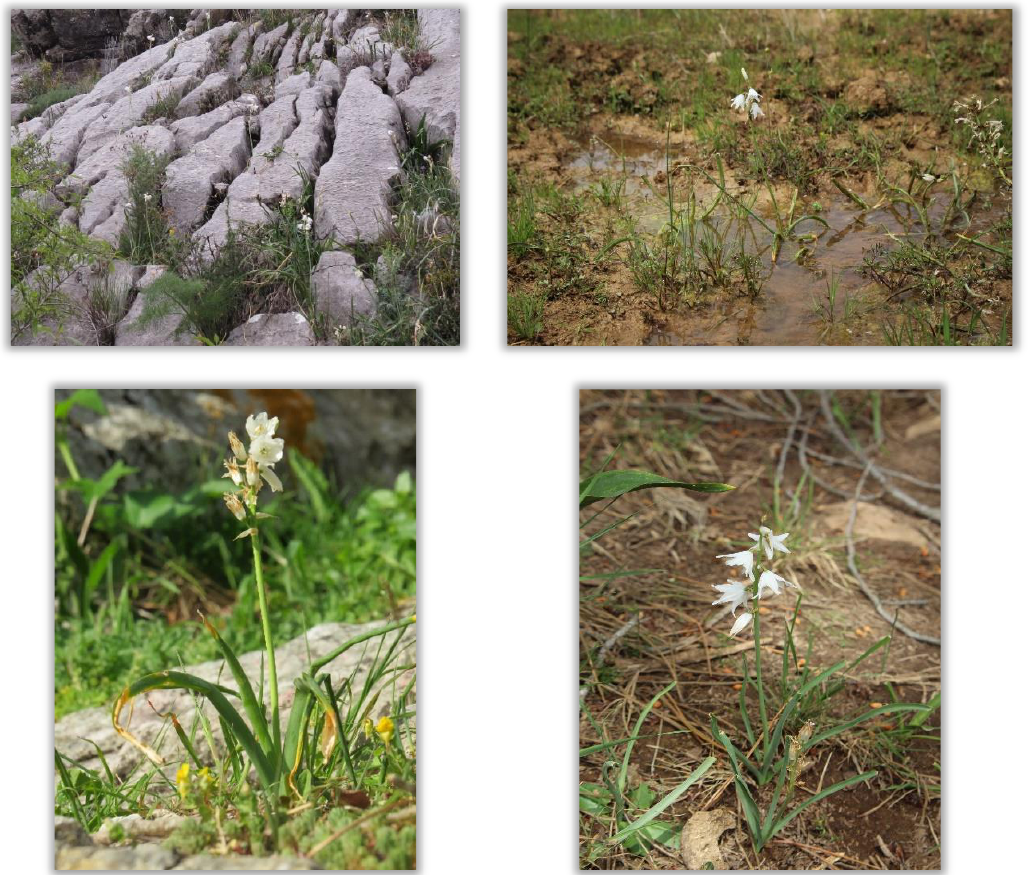
Figure 1. Photographs of the plant species (author: A.T.-A.). Western population: ALP ( upper left ) and VIL ( bottom left ). Eastern population: LV2 ( upper right ) and LV3 ( bottom right ). See Table 1 for acronyms and information on each location. Table 1. C. reverchonii samples collected and ecological conditions of sampling sites.